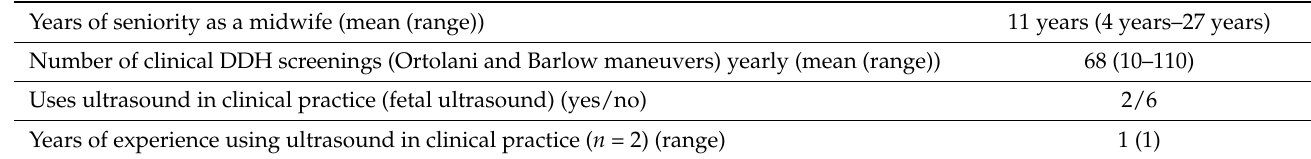
Table 1. Demographics of recruited midwives.